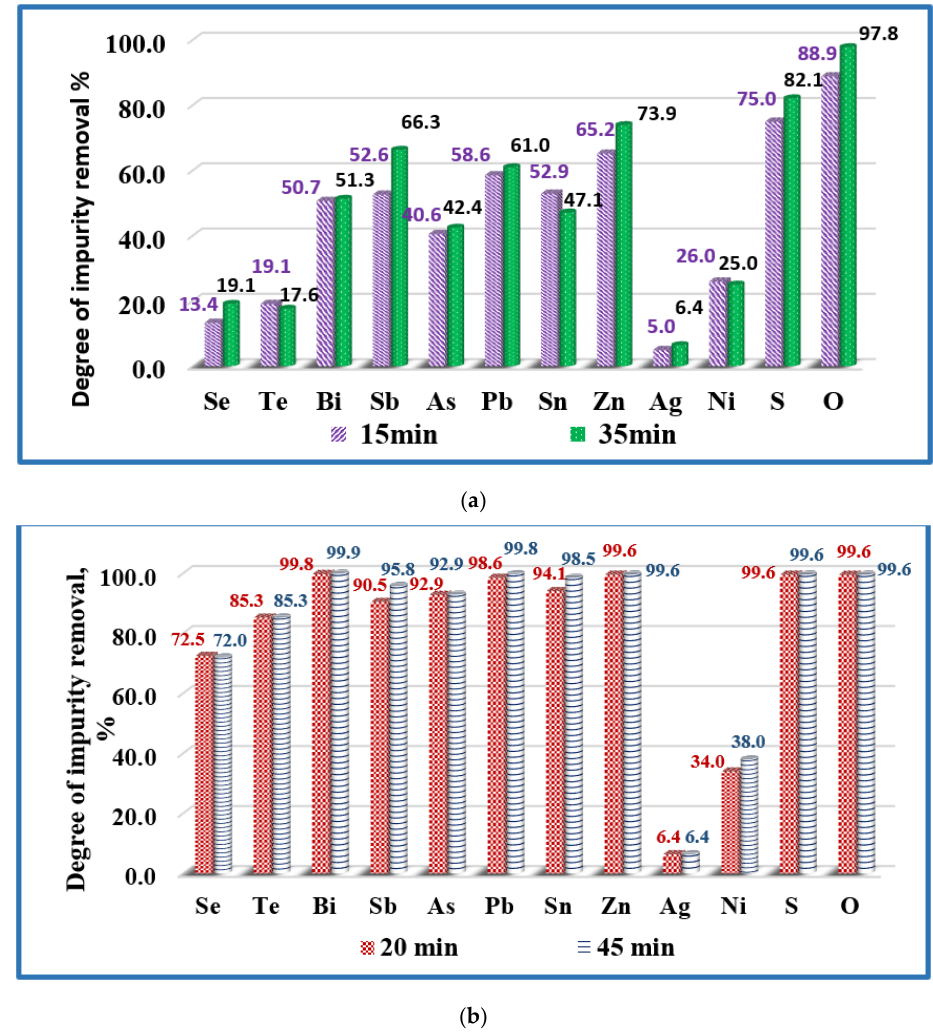
Figure 6. Influence of the melting time on the removal of impurities from copper technogenic material at temperatures: ( a ) T = 1500 K (samples Cu-02 and Cu-03); and ( b ) T = 1700 K (samples Cu-05 and Cu-06).